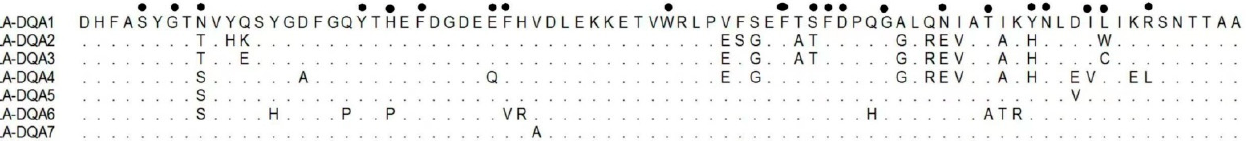
Figure 1. Amino acid sequences of MHC DQA alleles detected in the Przewalski’s horses. The amino acid residues were given in the international single letter code. A dot indicated that the amino acid was the same as in the consensus sequence. A solid point denoted an antigen binding site.